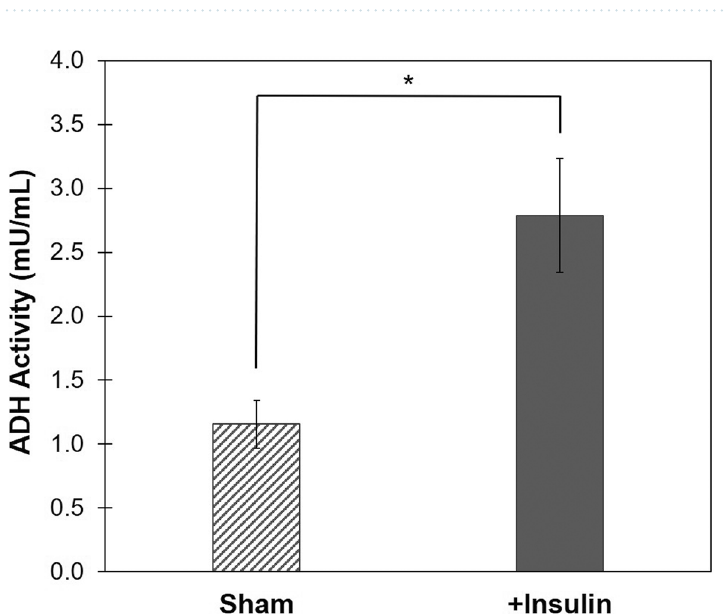
Figure 7. Insulin stimulates ADH1B enzymatic activity in adipocytes. Following differentiation, cultured adipocytes were starved for 12 h and treated with 1 µM insulin for 1 h (+ Insulin). Untreated cells were used as control (Sham). ADH activity was measured by a colorimetric assay (OD = 450 nm) that yields a proportional color change following ADH catalysis of isopropanol to produce NADH. ADH activity assay was performed in quadruplicate. Data is presented as the mean ± s.e.m. *P <